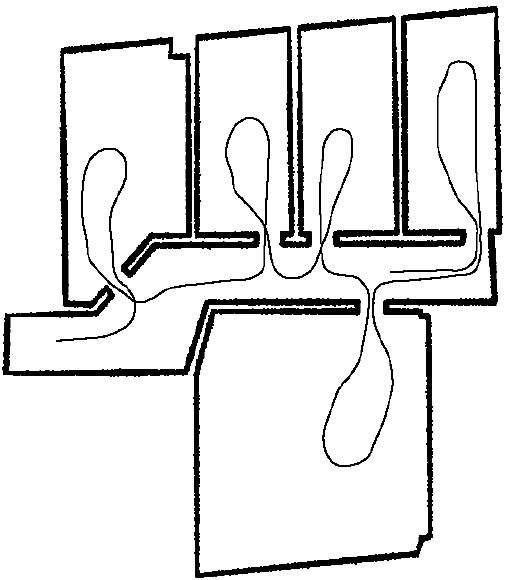
Figure 7. Point cloud resulting from the SLAM procedure together with the reconstructed